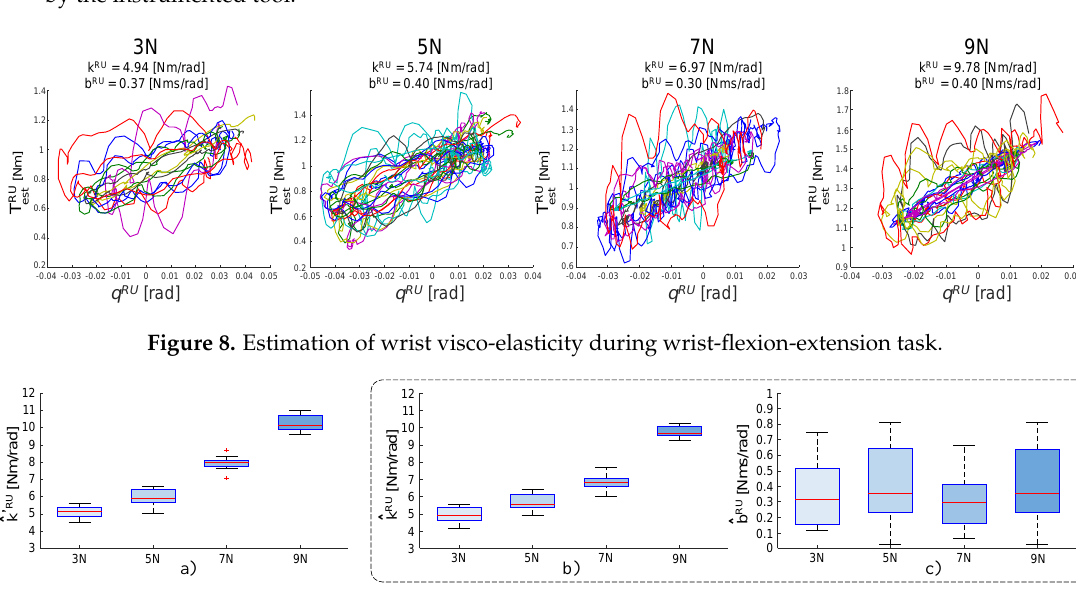
Figure 7. Results of the flexion-extension task. ( a ) The stiffness estimation is given from Equation (7). ( b ) The measured angle given from the motion capture. ( c ) The measured torque by the instrumented tool.